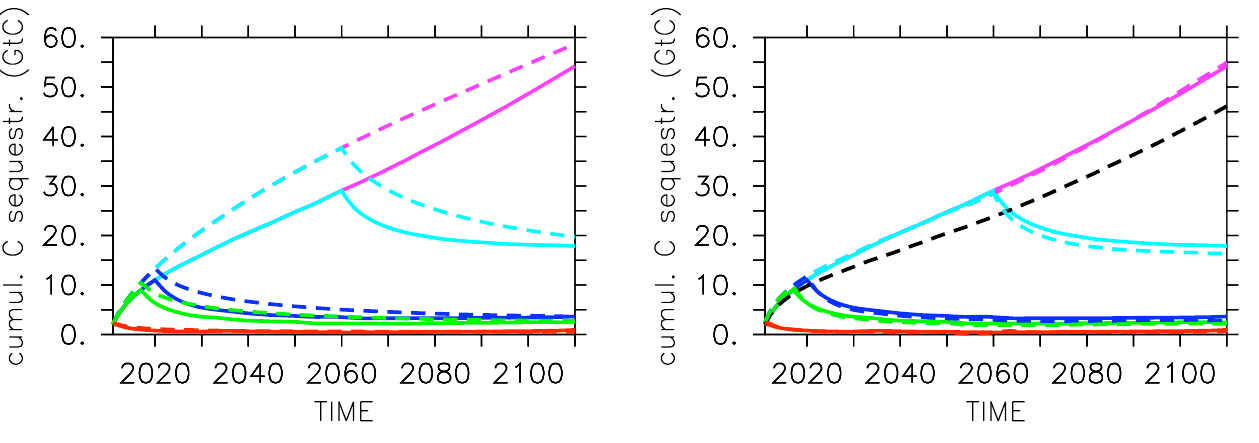
Fig. 12. Solid lines: Cumulative temporal integral of the fertilization-induced reduction in atmospheric CO 2 . Dashed lines: Cumulative temporal integral of the fertilization-induced change in global air-sea flux of CO 2 (same as solid lines in Fig. 6b). Units are GtC. Colour code as in Fig. 4.